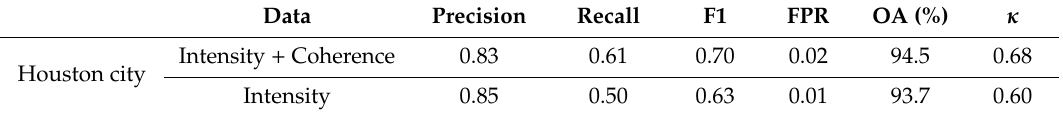
Table 5. Quantitative evaluation of the Houston flood case (FPR: false-positive rate, OA: overall accuracy). Data Precision Recall